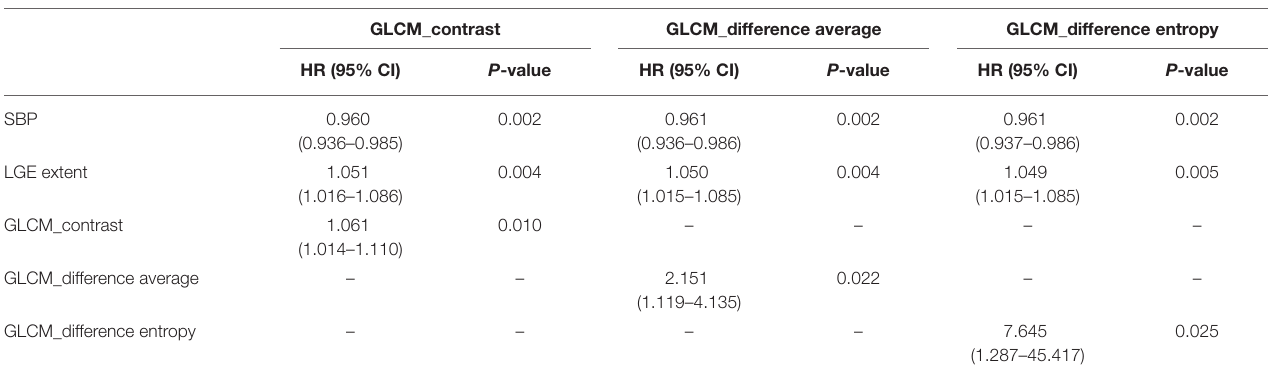
TABLE 5 | Multivariable Cox regression analysis incorporating texture